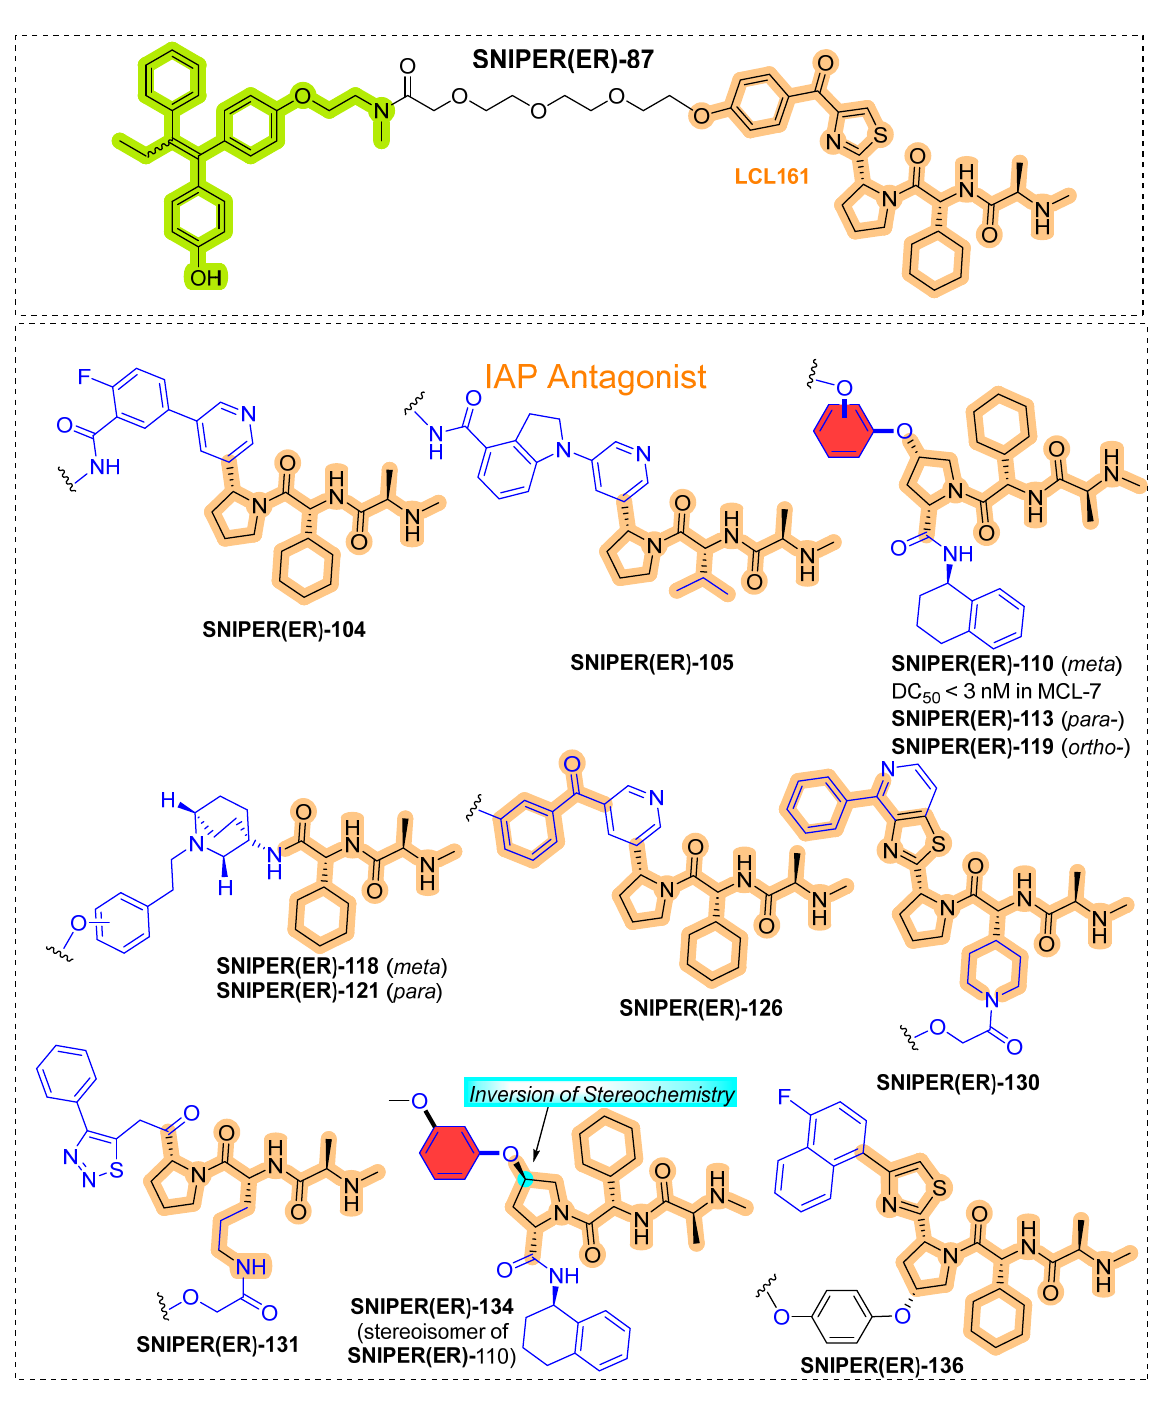
Figure 15. Various IAP structures studied to modify the SNIPER(ER)-87 . To comprehend the reasoning behind differential apoptosis induced by these SNIPER(ER)-105 , -110, and -126 in MCF-7 cells, but not in T47D cells, and these SNIPERs induce degradation of cIAP1 and XIAP more potently than SNIPER(ER)-87 , authors care- fully examined the effects of IAP depletion in MCF-7 and T47D cells. Silencing of cIAP1 and XIAP by siRNA somewhat reduced the number of MCF-7 cells, while combined